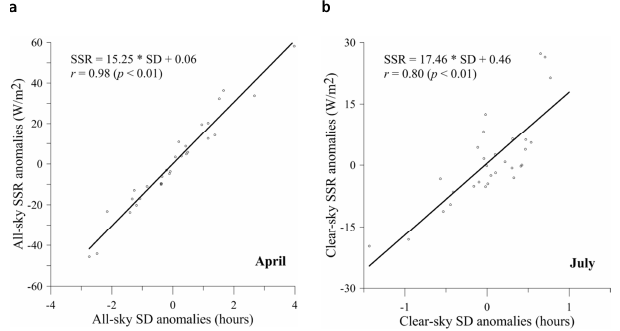
Fig. 2. Scatterplot of the mean monthly series in April for all-sky (a) and July for clear-sky (b) SSR versus SD in Switzerland during the 1981–2010 period. The anomalies are expressed as differences from the 1981–2010 mean, and the best fit line is indicated in each plot, together with their linear regression equations and correlation